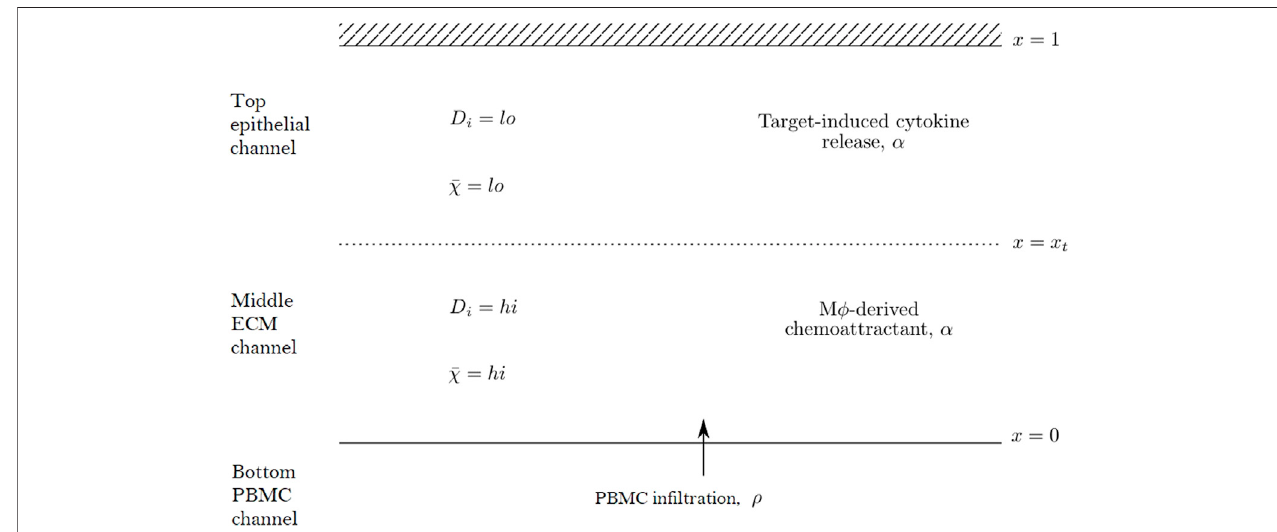
FIGURE 2 | Schematic diagram of the mathematical domain used to model the PBMC in fi ltration dynamics in the top two channels of the Mimetas Organoplate chip. The interface with the bottom channel is given by x = 0, while x = x t denotes the interface between the middle and top channels. The diffusivity parameters, D i , and chemotactic sensitivity, ~ χ , vary spatially as given by Eq. 4 , with cells moving more freely in the middle channel corresponding to higher (hi vs. lo) parameter values. Cytokine production may occur in both channels via two distinct